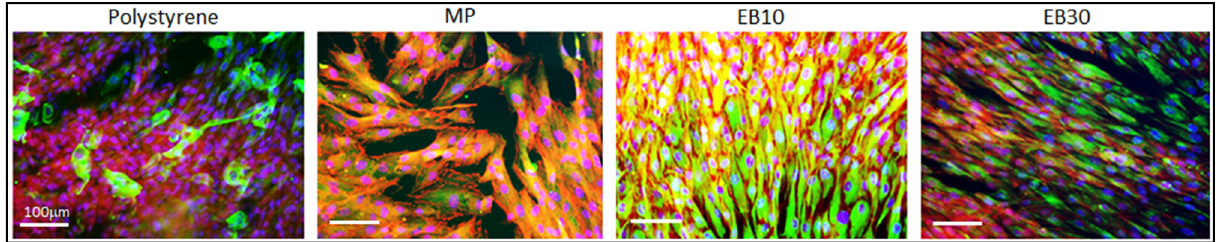
Figure 6. Cells’ morphology and orientation after 48 h cultivation. A random orientation was observed for the polystyrene and MP specimens, while in EB10, cytoskeletons were oriented following surface grooves as stained by F-actin (red, phalloidin) and intermediate filaments (green, vimentin). The number of nuclei (stained in blue by DAPI) suggested for a comparable colonization.